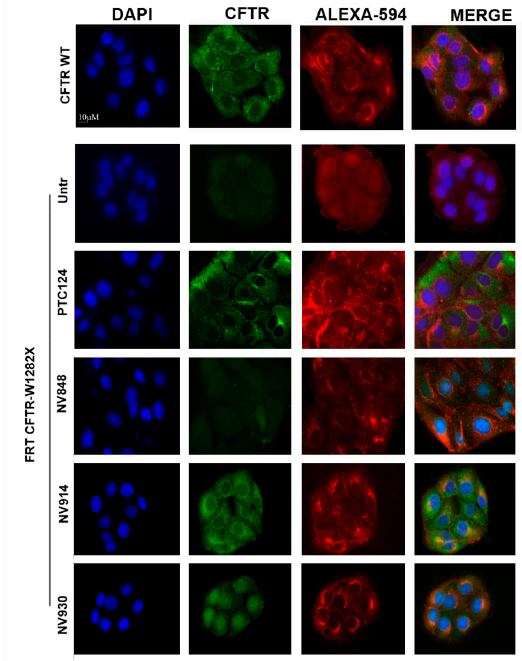
Figure 7. Immunofluorescence analysis of the full-length CFTR protein in wild-type (CFTR-WT) and CFTR W1282X FRT cells, untreated (Untr) or treated with 12 µ M PTC124, NV848 , NV930 , or NV914 for 24 h. CFTR protein was revealed by a specific antibody (ab570-green). Nuclei (blue) were DAPI-stained and the cellular membrane was stained by WGA-Alexa 594 (red).